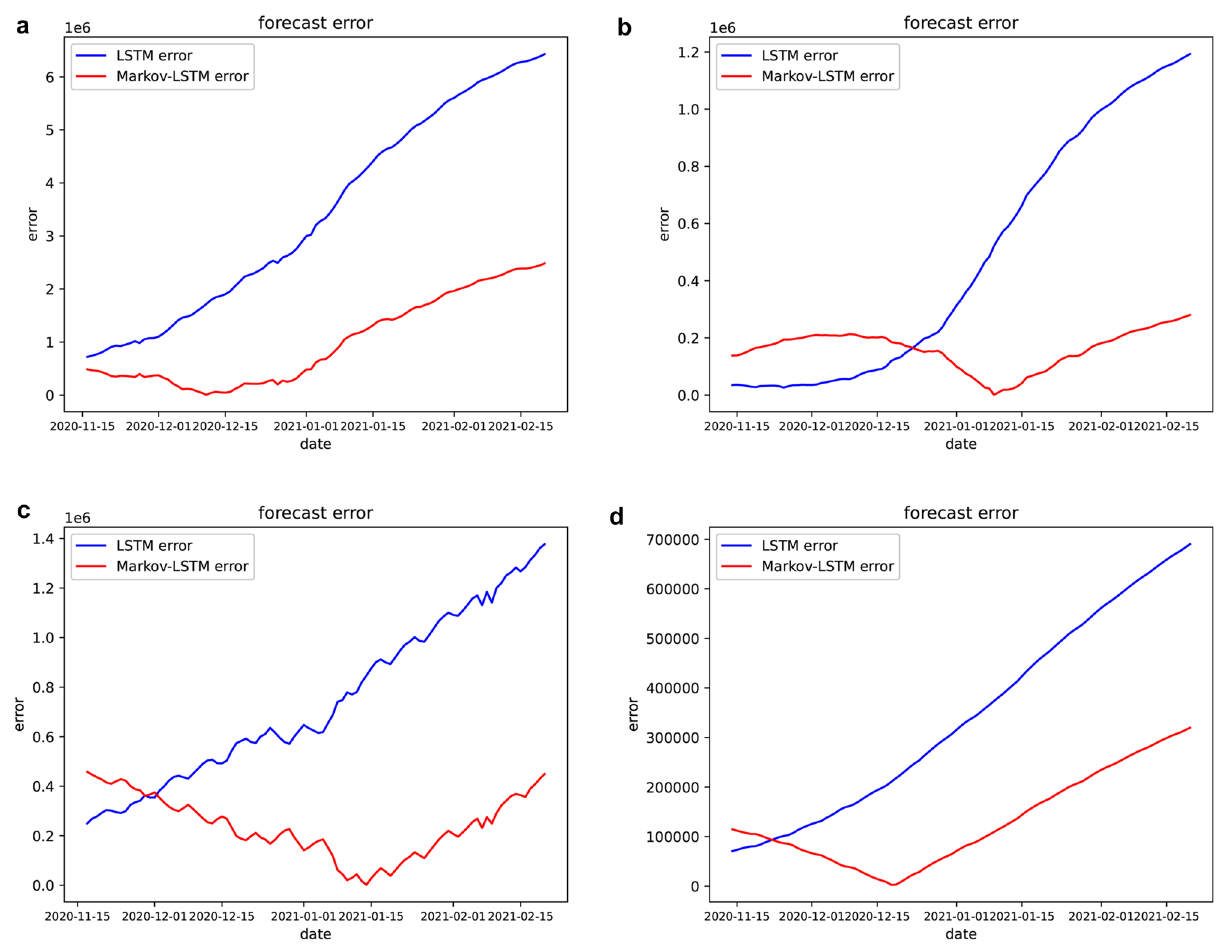
Figure 7. Comparison of forecast errors by countries. ( a ) In the United States, ( b ) in Britain, ( c ) in Brazil, ( d ) in Russia. The blue line represents the results of the LSTM model, the red line represents the results of the LSTM- Markov model (Figure was edited by the